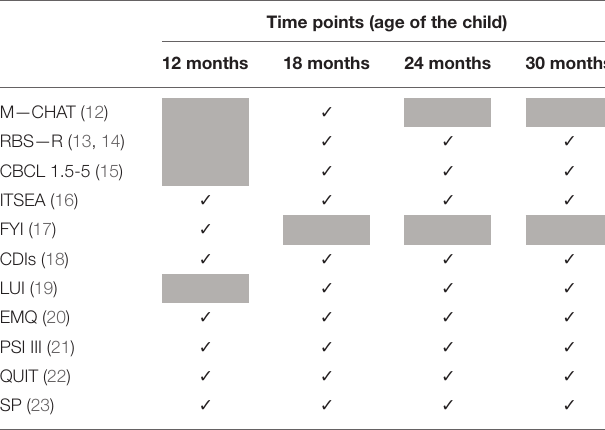
TABLE 2 | The questionnaires administered to parents at each time point of the EARLY BIRD surveillance protocol. Time points (age of the